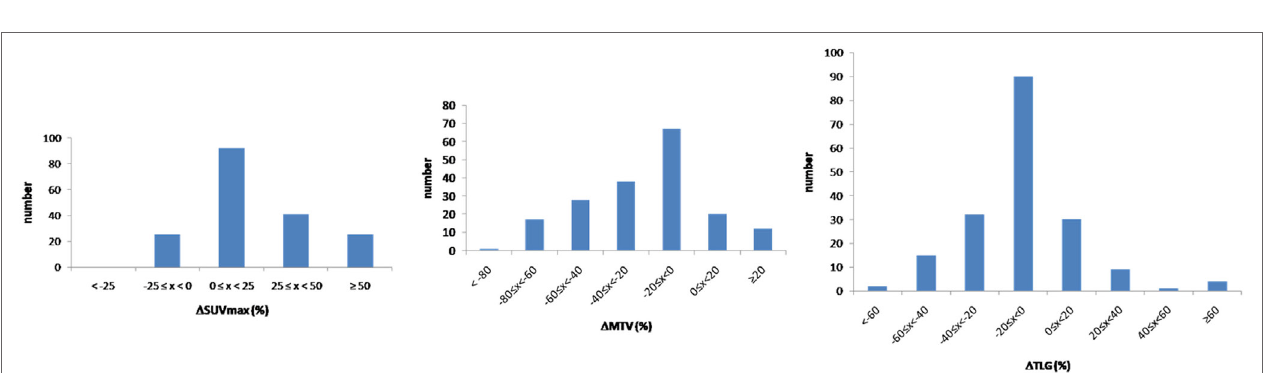
FigUre 2 | Signal-to-noise ratio (SNR) and contrast-to-noise ratio (CNR) in respiratory-gated and non-gated images.